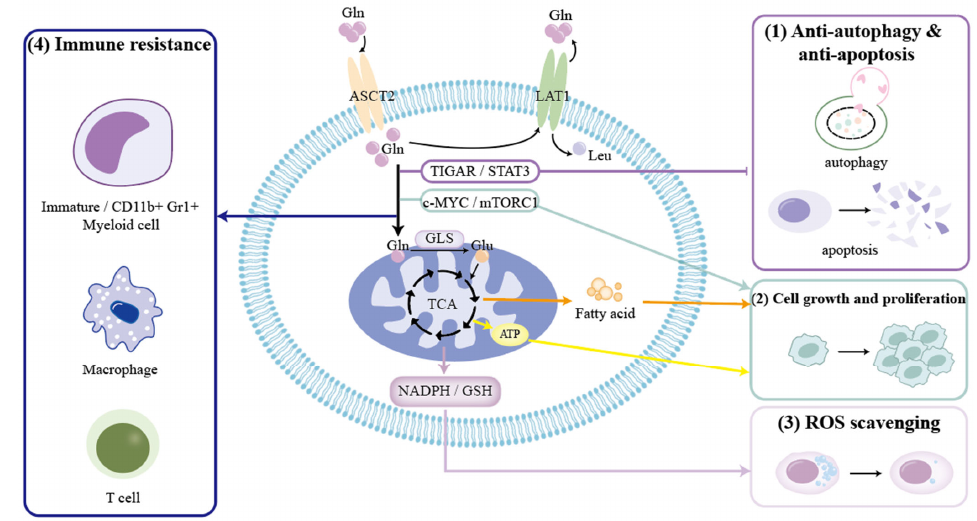
Figure 2. Effect of glutamine metabolism on endocrine ‐ related cancers. Table 2. Influence of glutamine metabolism on endocrine ‐ related cancers.